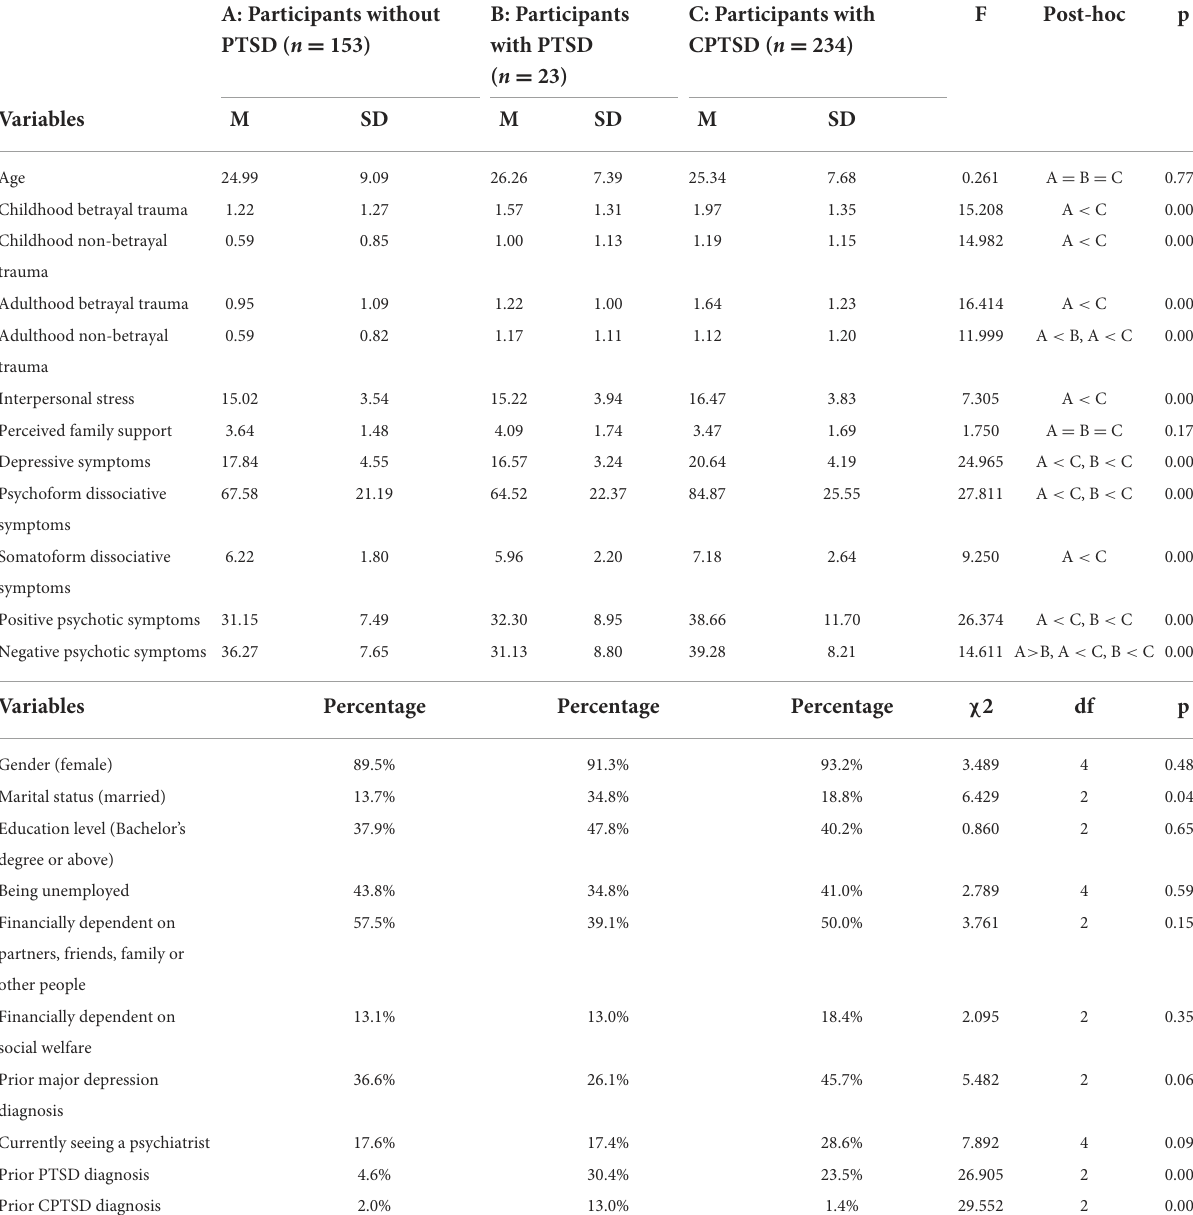
TABLE 2 Differences between participants with and without (complex) post-traumatic stress disorder (C) PTSD ( N = 410). A: Participants without PTSD ( n = 153)